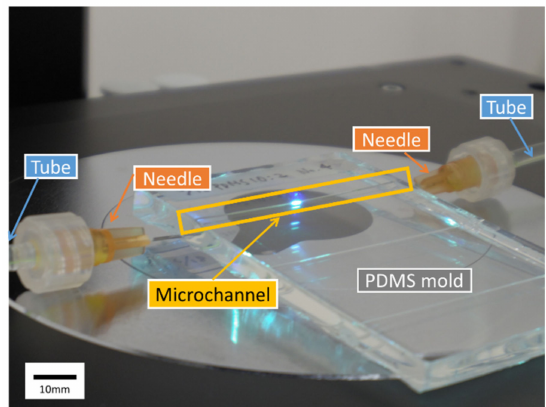
Figure 1. Circular polydimethylsiloxane (PDMS) microchannel in the PDMS mold. Needles were inserted on both sides of the microchannel and connected by